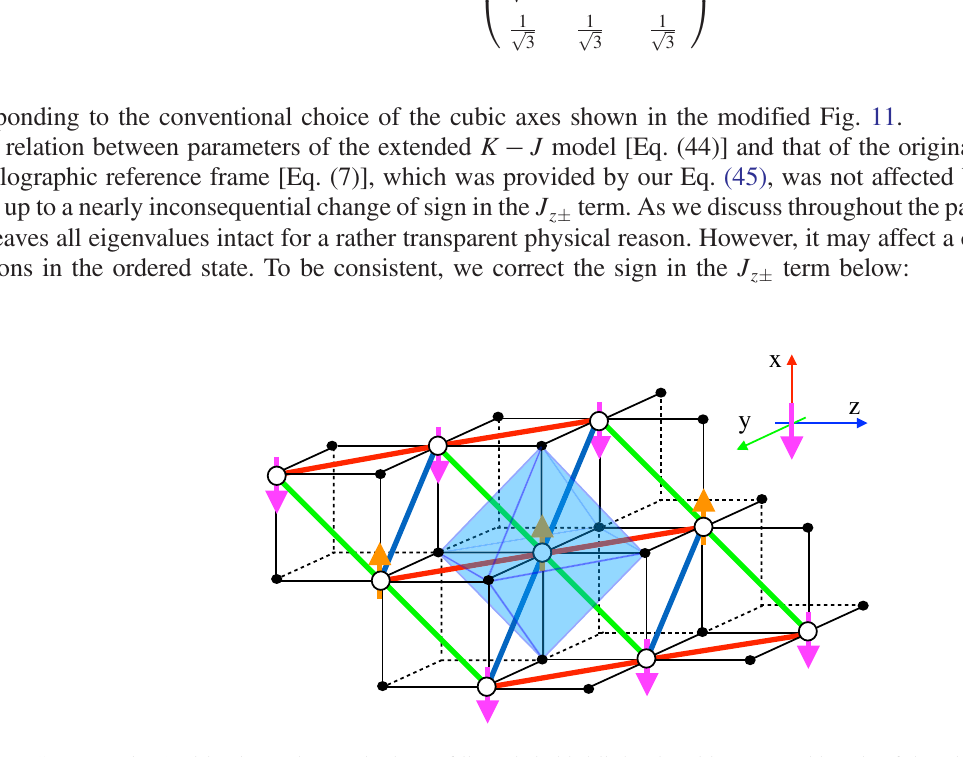
Published by the American Physical Society under the terms of the Creative Commons Attribution 4.0 International license. Further distribution of this work must maintain attribution to the author(s) and the published articles title, journal citation, and DOI.